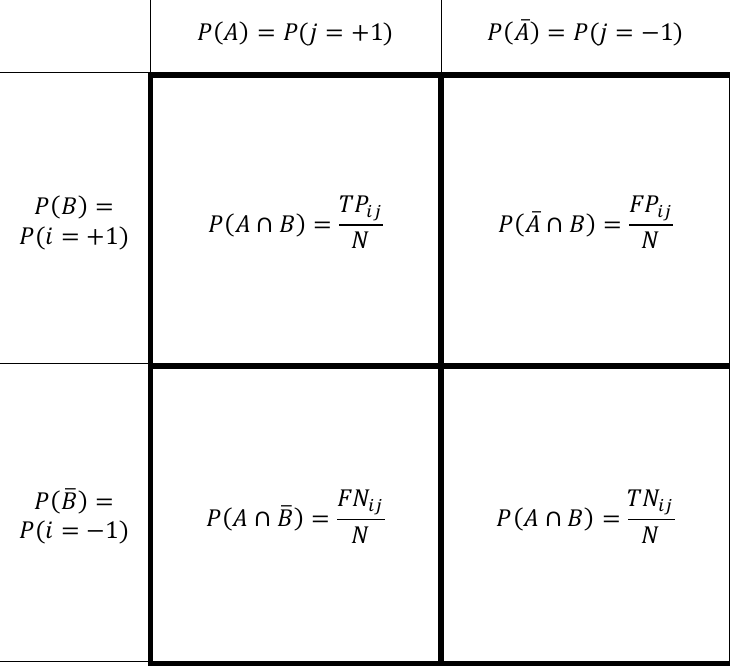
Figure 2. The contingency matrix in Figure 1 normalized as a unit square representing a Universe of Discourse involving the two events 𝐴 and 𝐵 without area proportionality. The matrix has fractional non- negative entries that add up to